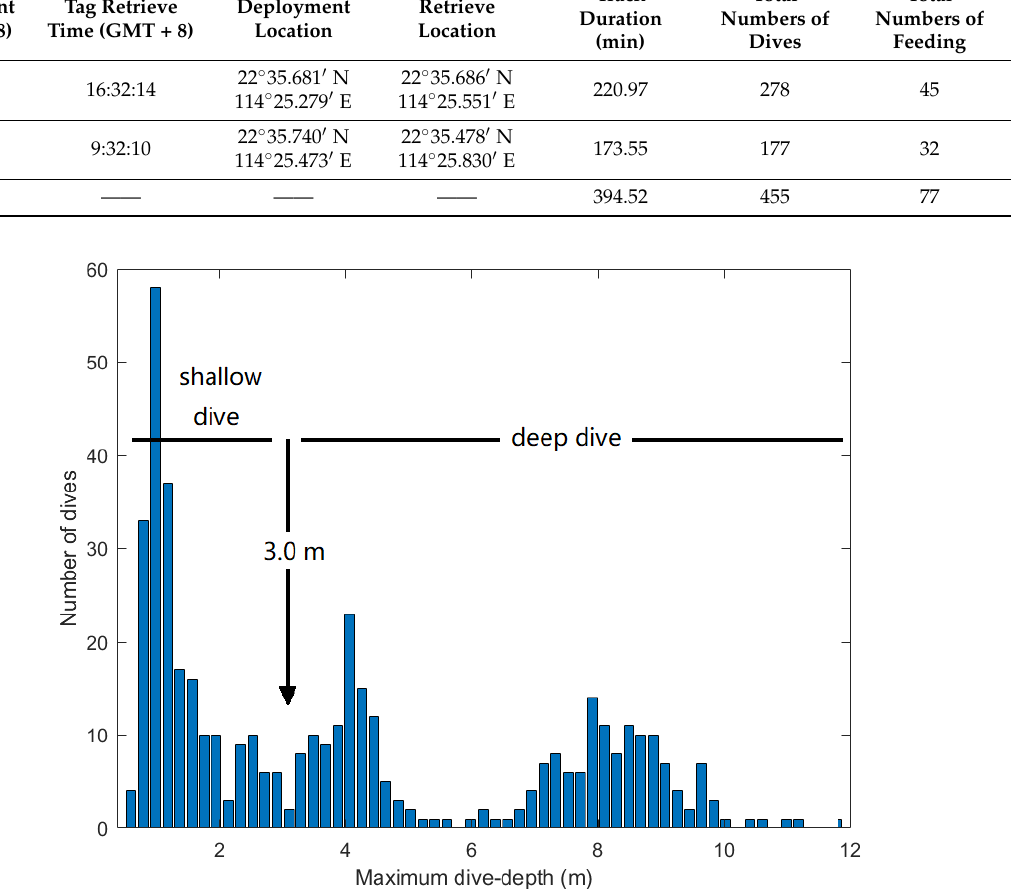
Figure 3. The distribution of maximum depth in each dive ( n = 455). The shallow and deep dives are distinguished with depth boundary at 3.00 m.